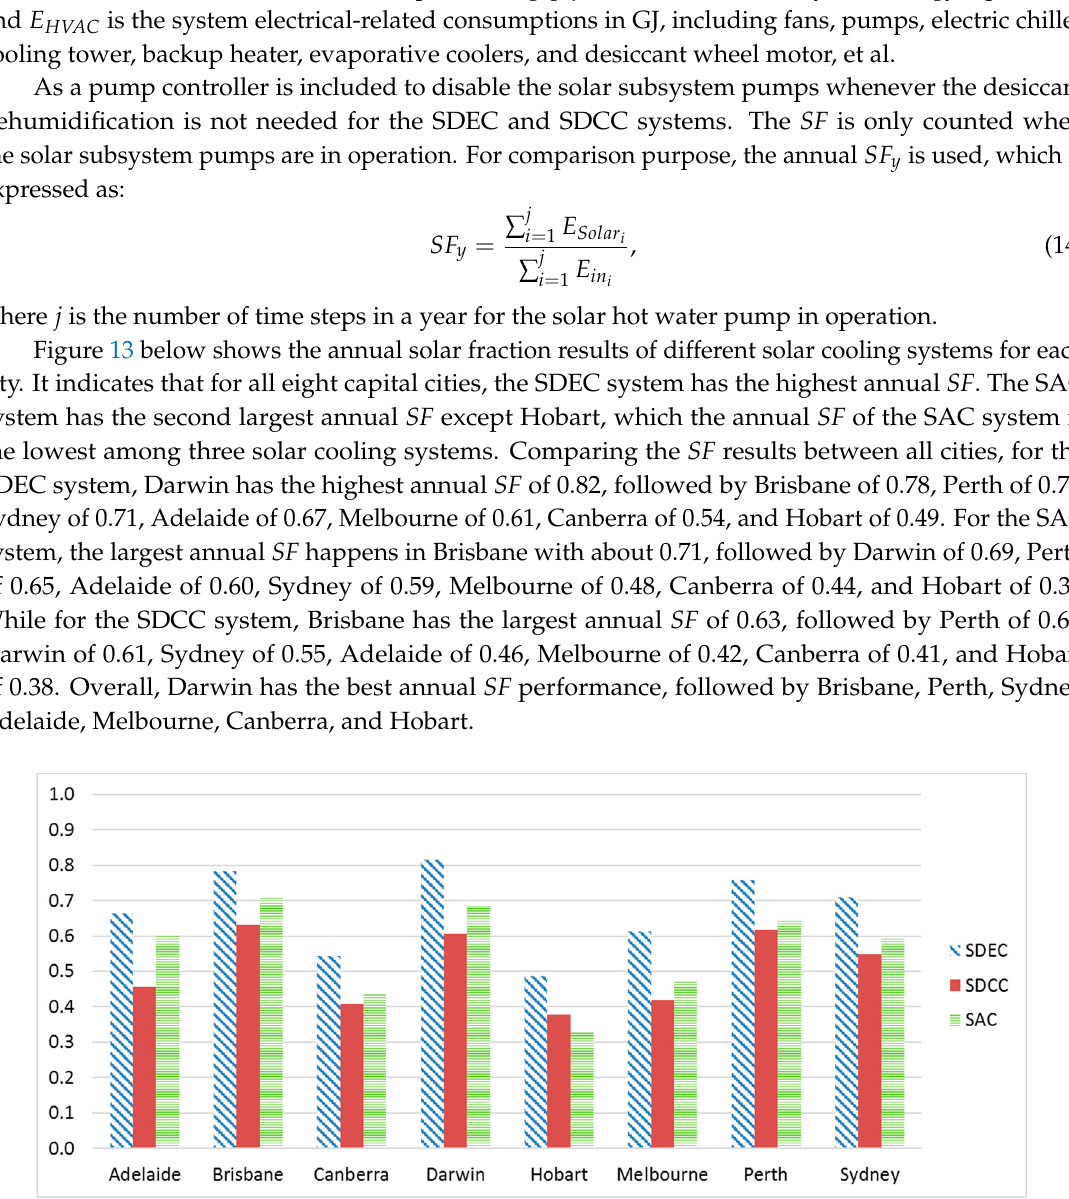
Figure 14. Correlation between outdoor air humidity ratio and annual SF . 3.1.2. System Coefficient of Performance In this study, system electric COP is evaluated, which refers to the ratio of the system cooling demand to the total HVAC electricity consumption from the municipal electricity network. It can be expressed in Equation (15) below: